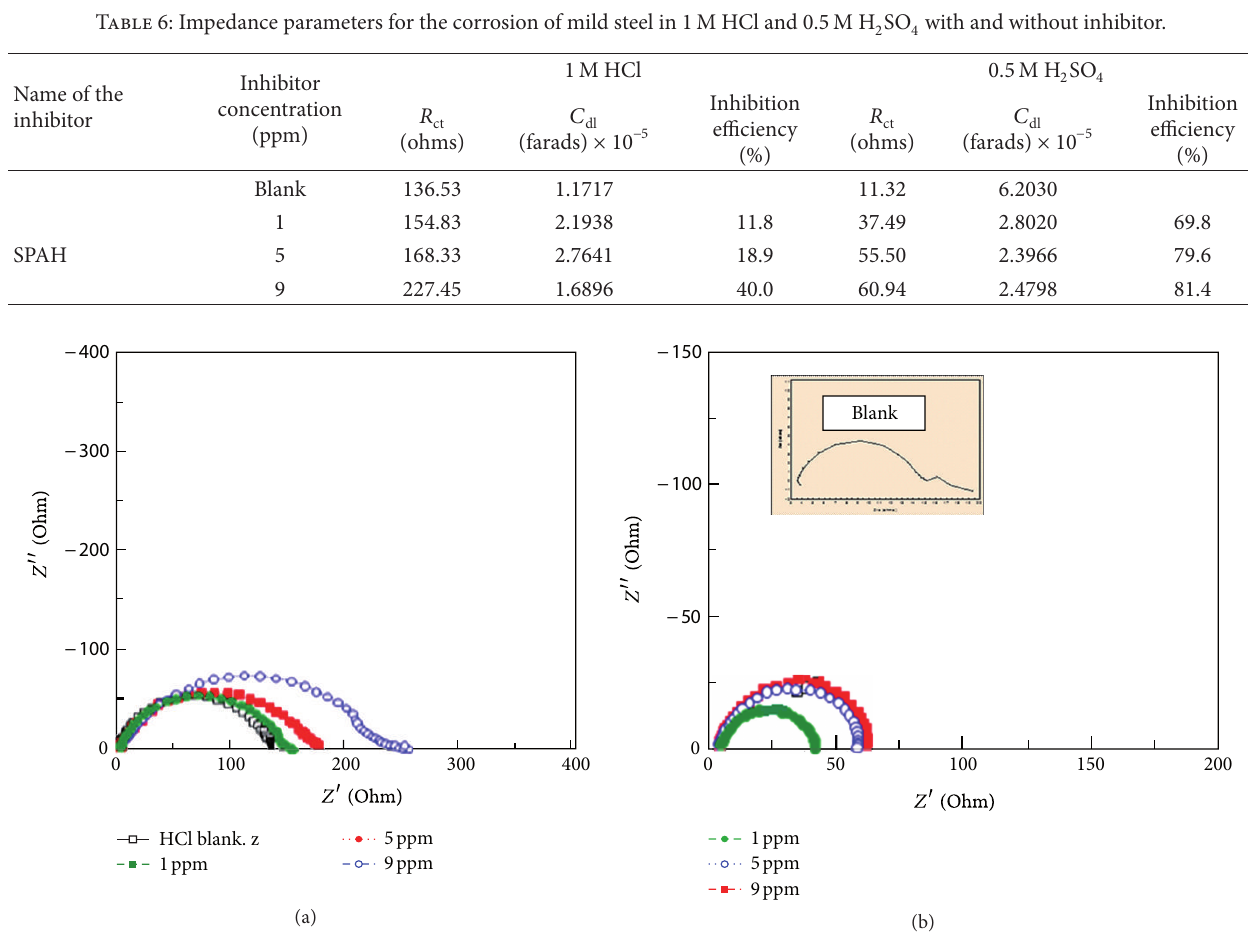
T 6: Impedance parameters for the corrosion of mild steel in 1M HCl and 0.5M H